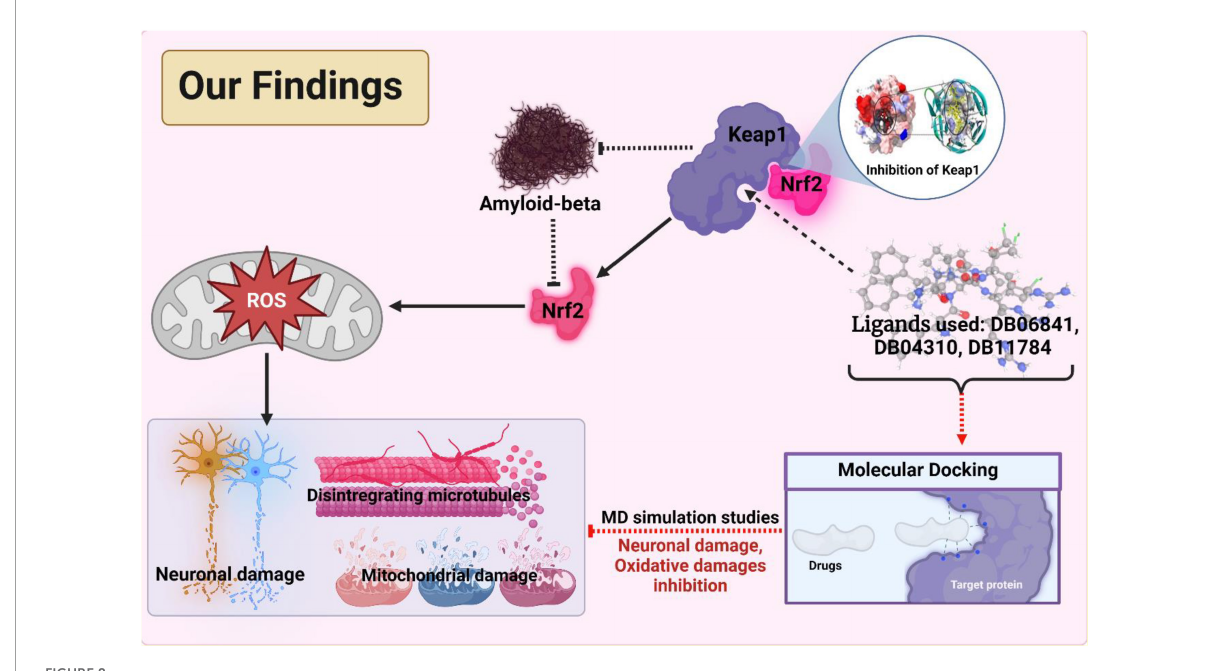
FIGURE8 The outcomes and findings in our research show the active inhibition of the target protein. Adopted from